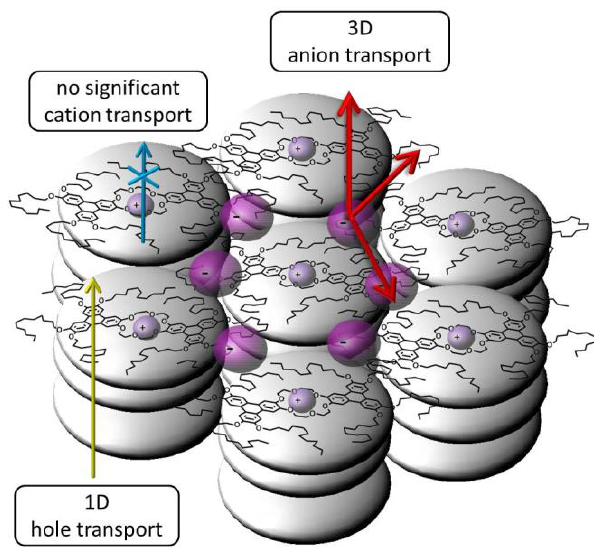
Figure 15. Our new mesogenic bi-centred ion complexes form highly ordered columnar mesophases providing improved quasi one-dimensional (1D) hole transport. The cations are coordinated strongly by the central crown ether moieties showing no significant contribution to the ionic conductivity. The anions are mobile in the anisotropic liquid like side chains. Supplementary Materials: The following are available online at http: // www.mdpi.com / 2073-4352 / 9 / 2 / 74 / s1. Figure S1: KI-2b in the columnar state ( p 2 mg ) (left) and in the solid state g (right). The texture shows no significant di ff erences. Figure S2: DSC curves of the complexes KSCN-2b (a) and KSCN-2c (b). Heating / cooling rate 10 K / min. Figure S3: WAXS pattern of KSCN-2b taken from ref. [1]. Figure S4: Wide angle di ff raction pattern of LiI-1b ( ) and KSCN-2c ( (cid:3) ) in the solid state. Only di ff use smeared peaks can be observed indicating a low intra-columnar order. Figure S5: Absorbance spectrum of neat 2b ( (cid:4) ) and its KSCN-complex KSCN-2b ( (cid:8) ) in the (cid:35) solid state. Figure S6: Photoconductivity profiles of a segregated sample of KSCN-2b ( ∆ ) where both components contribute to the photocurrent in the respective temperature ranges. Furthermore, the profile of neat 2b ( (cid:8) ) and a KSCN-2b sample ( ) where only the complex contributes are shown. Figure S7: Large scale pictures of the aligned thin films of KI-2b between crossed polarizers in the bright state (left) and the dark state (right). The columns (cid:35) have been aligned parallel (A, B) and perpendicular (C, D) to the electric field. Figure S8: Temperature dependent ionic conductivity in thick films of KI-2b with columns aligned randomly ( (cid:3) ), parallel ( (cid:8) ) and perpendicular ( (cid:78) ) to the electric field. Table S1: Small angle X-ray data of KSCN-2b . θ is the scattering angle, hk the Miller indices, d ob and d cal are the observed and calculated distances while a and b are the lattice constants for the rectangular unit cell. Table S2: XRD data of KSCN-2b taken from ref. [1].